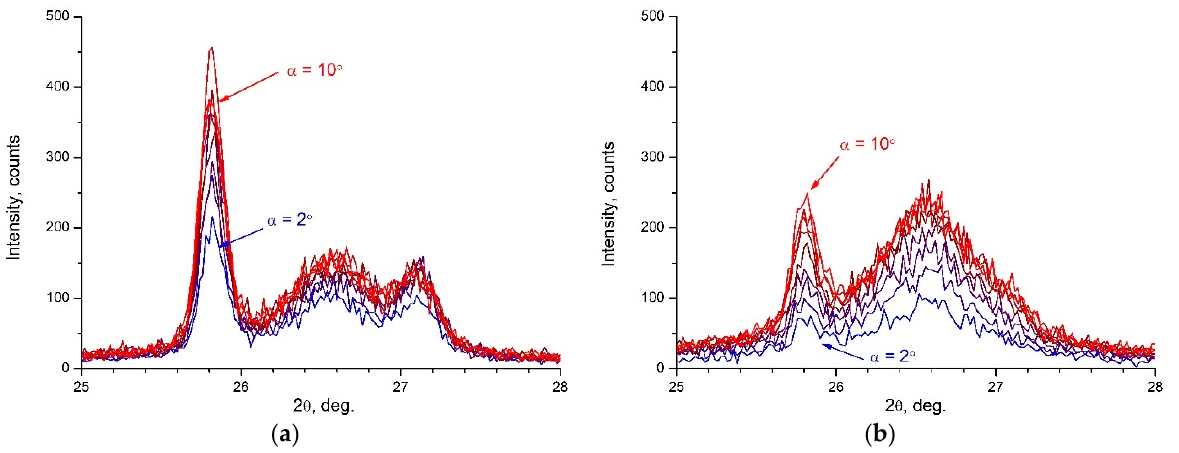
Figure 9. GIXRD analysis of 200 reflections of the YPO 4 :Gd ceramic samples: ( a ) initial state; ( b ) after irradiation with Xe +26 ions with a fluence of 7 × 10 12 cm − 2 .